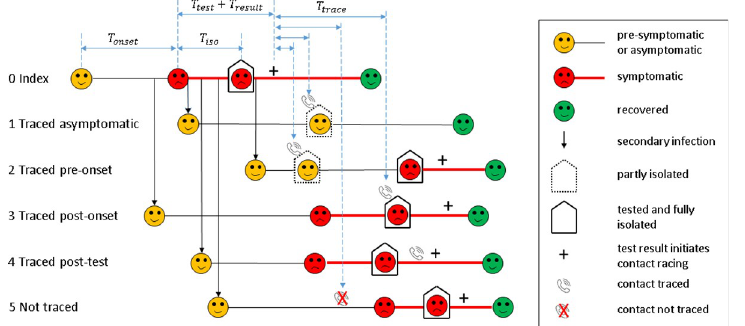
Fig 1. Schematic diagram of the contact tracing model. Infected individuals are initially not symptomatic (yellow). Some infections eventually develop symptoms (red), others remain asymptomatic for the duration of infection. For the index case who was not traced (0), there is a delay between onset of symptoms (red) and getting tested. Isolation occurs at some point between symptom onset and testing. There is a subsequent delay from testing to the test result being returned (+) and tracing of contacts. Traced contacts (1–4) are quarantined when contacted by public health officials (phone icons) and are isolated and tested immediately on symptom onset. Traced contacts (3) who are already symptomatic prior to being traced are isolated immediately when contacted. Traced contacts (4) that have already isolated prior to being traced are not affected. Contacts that cannot be traced (5) may still get tested and isolated after developing symptoms, but this is likely to take longer. Asymptomatic infections (1) do not get tested or isolated, but will be quarantined if they are a traced contact. Some asymptomatic infections may be untraced, in which case they will not be quarantined or isolated (not